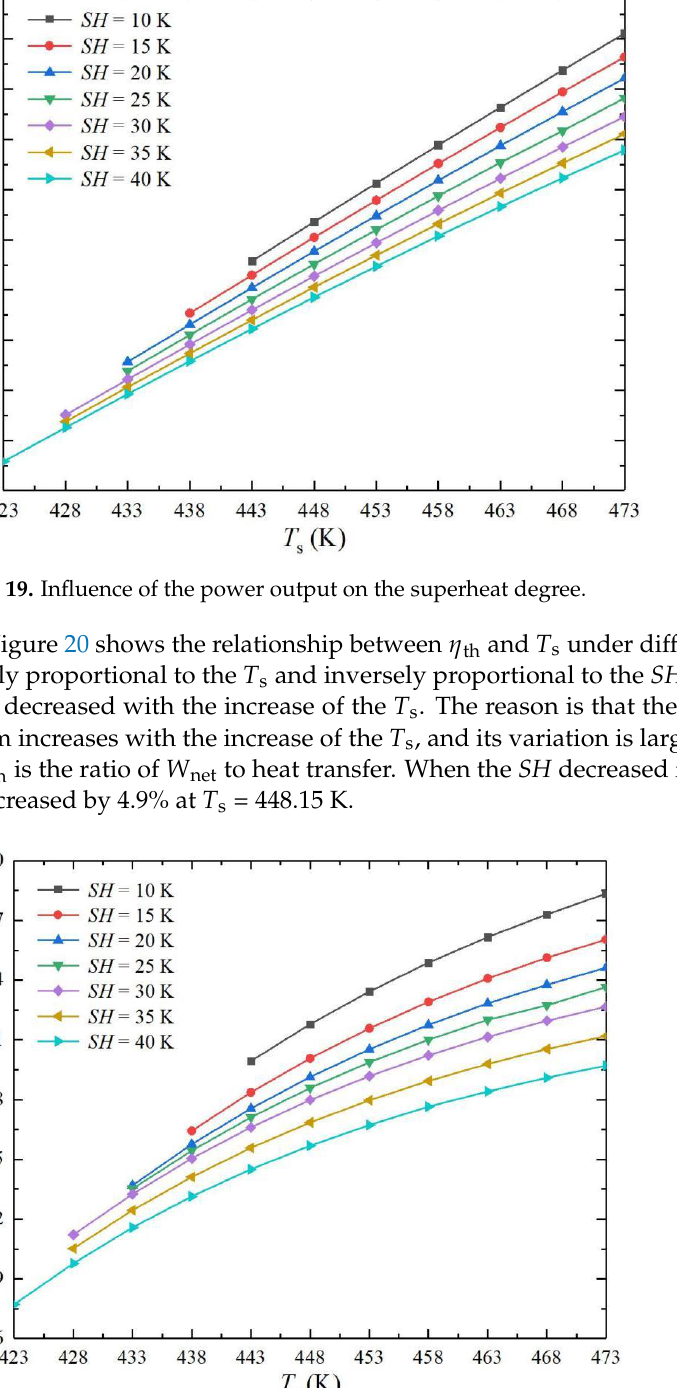
Figure 18. Power output of the expander with heat-source temperatures under different superheat degrees.